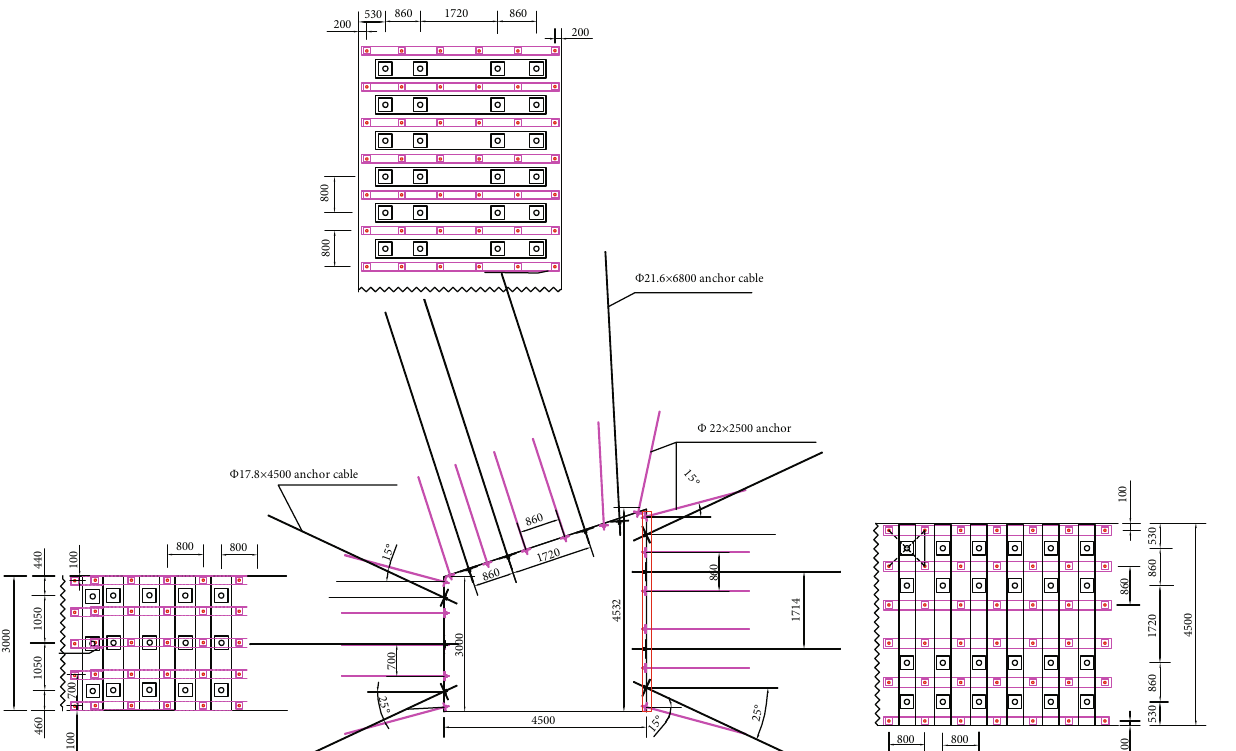
Figure 16: 3206 return airway support (unit: